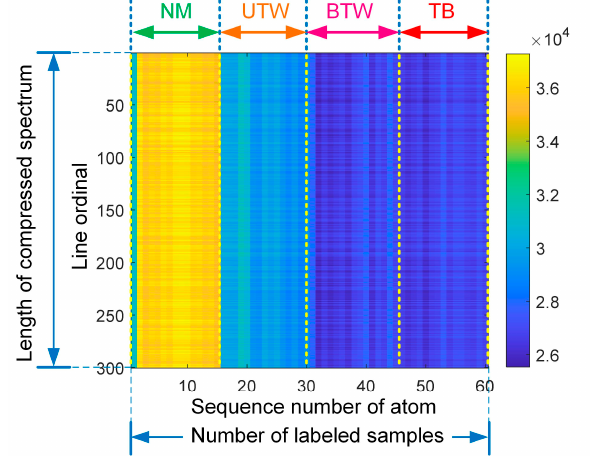
Figure 25. RPD: dictionary matrix.